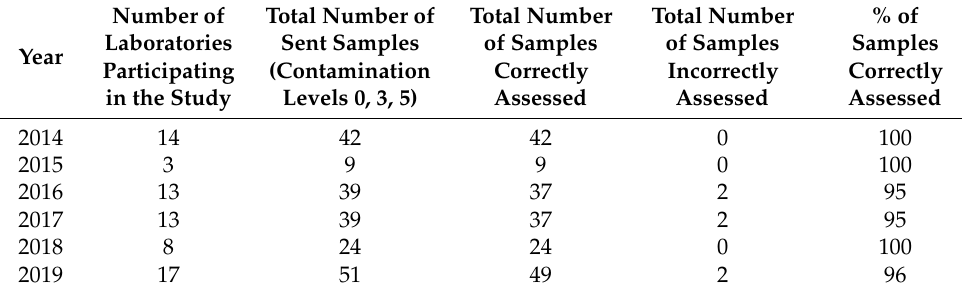
Table 1. Sample qualitative results of PT from 2014 to 2019.